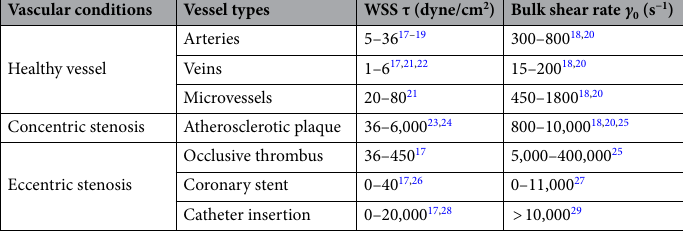
Table 1. Physiological and pathological shear rate ranges of in vivo circulating